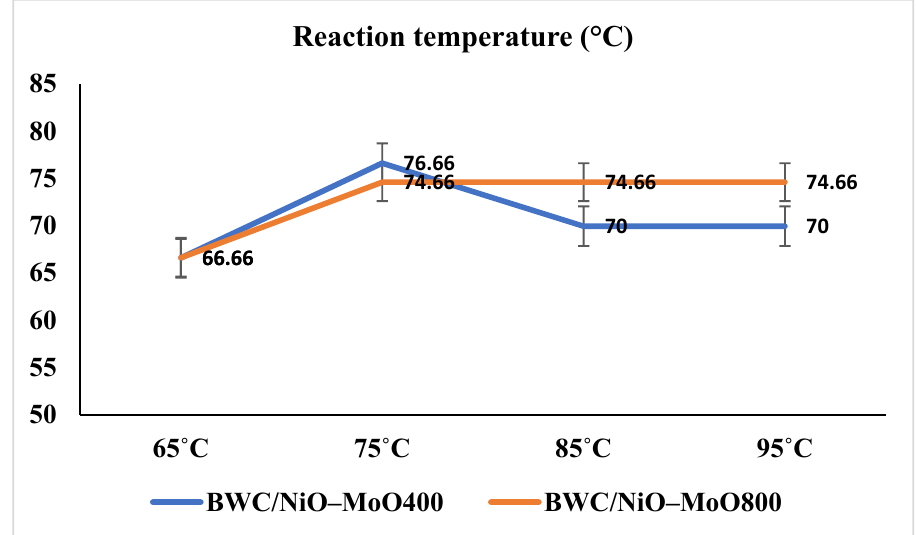
Figure 1. Biodiesel yield (%) obtained at various reaction temperatures (°C) of biochar woodchip.